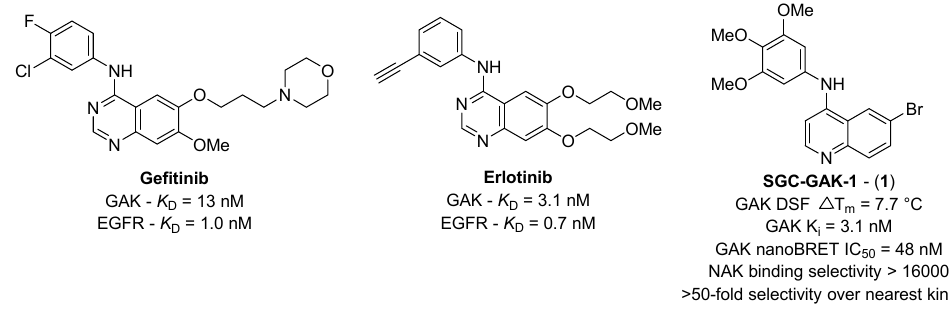
Figure 1. Examples of reported GAK inhibitors.